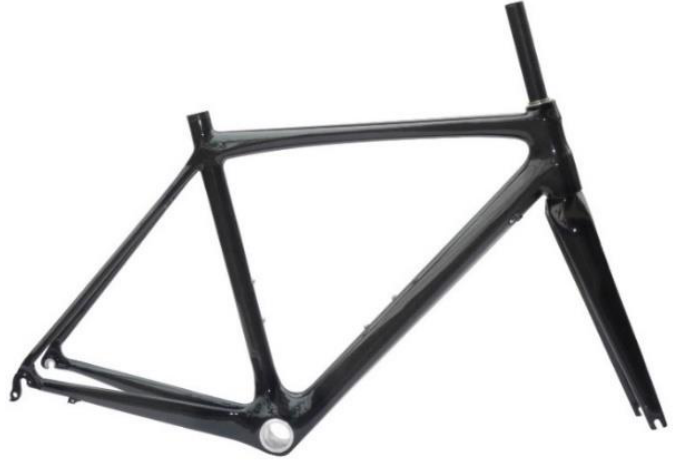
Figure 20. Carbon/epoxy composite bicycle frame weighing much less than the corresponding steel frame (reprinted with permission from Ref. [63]).